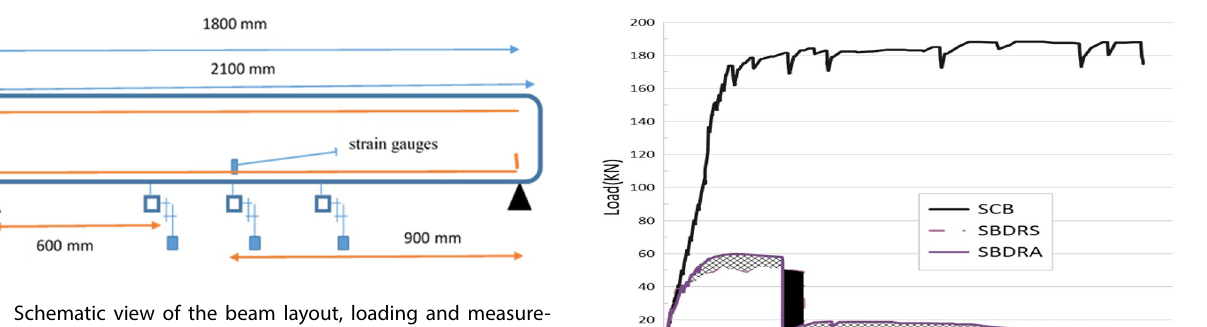
Fig. 5 Schematic view of the beam layout, loading and measure- ment instruments